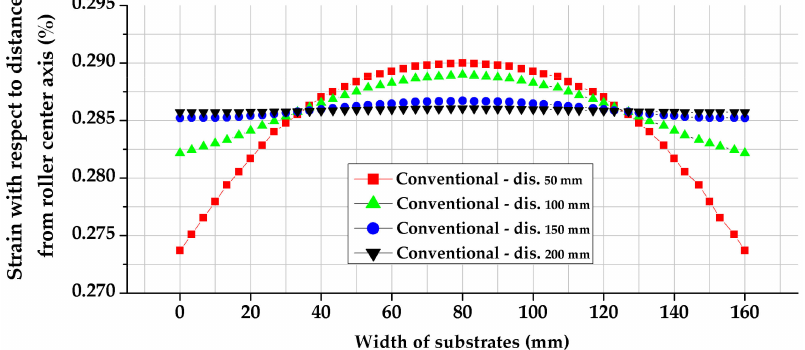
Figure 2. MD strain distribution along the printing line with respect to the change in distance between roller and